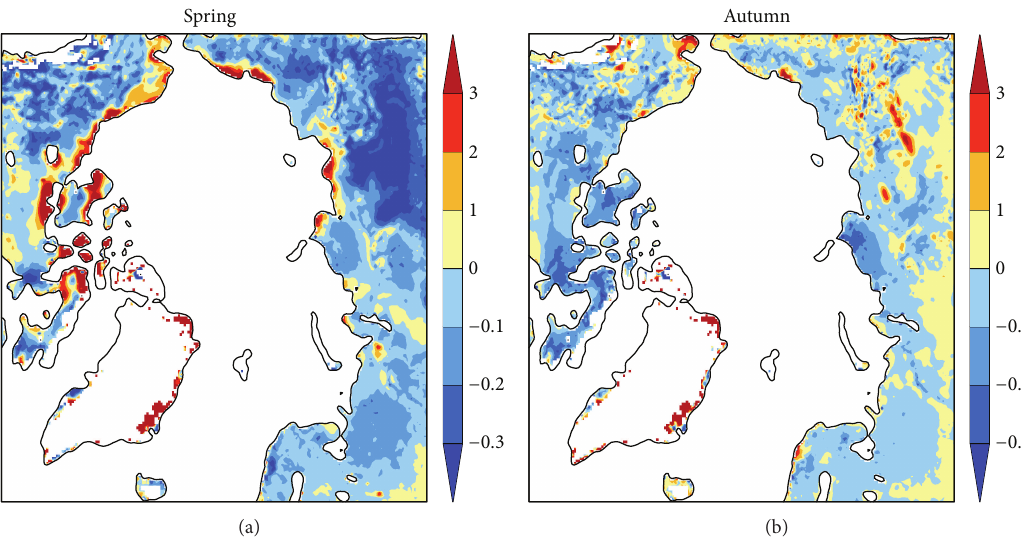
Figure 11: Land surface temperature difference “HIRHAM5 minus ERA-Interim” (K) averaged over 2008–2010 for spring (a) and autumn (b).